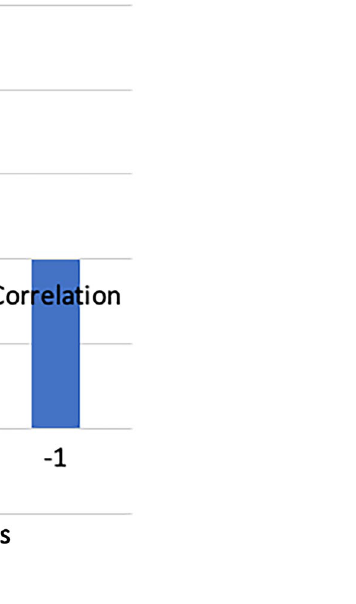
Figure 10. Br Score for texture